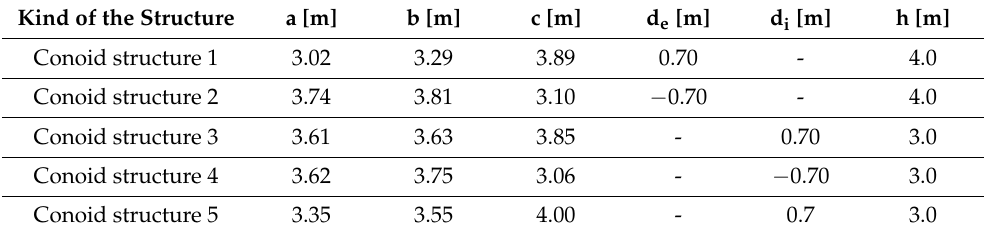
Table 2. Characteristic dimensions of various roof structures with conoid